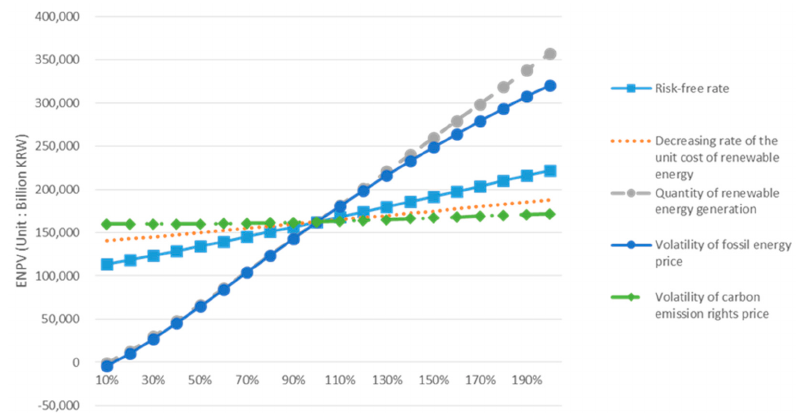
Figure 7. Results of sensitivity analyses on expanded net present value (ENPV).